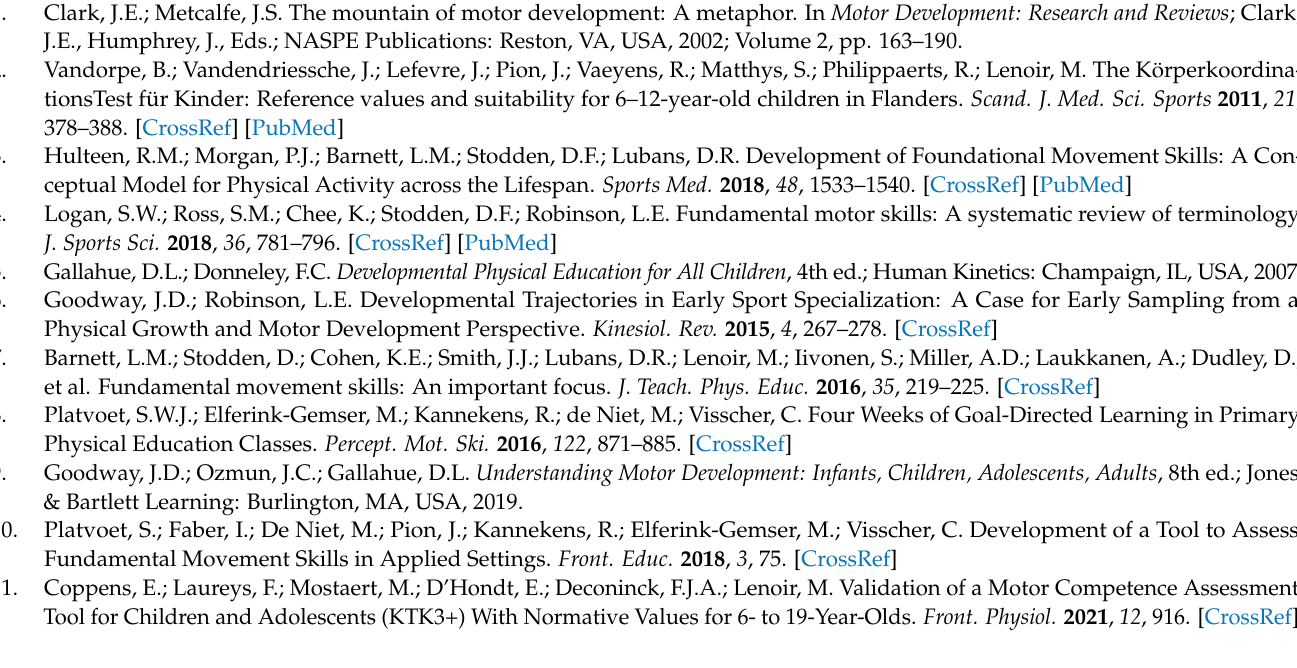
proficiency level for the walking backwards test; Table S2: Number of children, mean age ( ± standard deviation) and mean score ( ± standard deviation) at T0 and T1 per grade, gender, and proficiency level for the moving sideways test, Table S3: Number of children, mean age ( ± standard deviation) and mean score ( ± standard deviation) at T0 and T1 per grade, gender, and proficiency level for the jumping sideways test, Table S4: Number of children, mean age ( ± standard deviation) and mean score ( ± standard deviation) at T0 and T1 per grade, gender, and proficiency level for the eye hand coordination test, Table S5: Percentage of children with negative (NED), no (NOD), and positive (POD) development per grade, gender, and proficiency